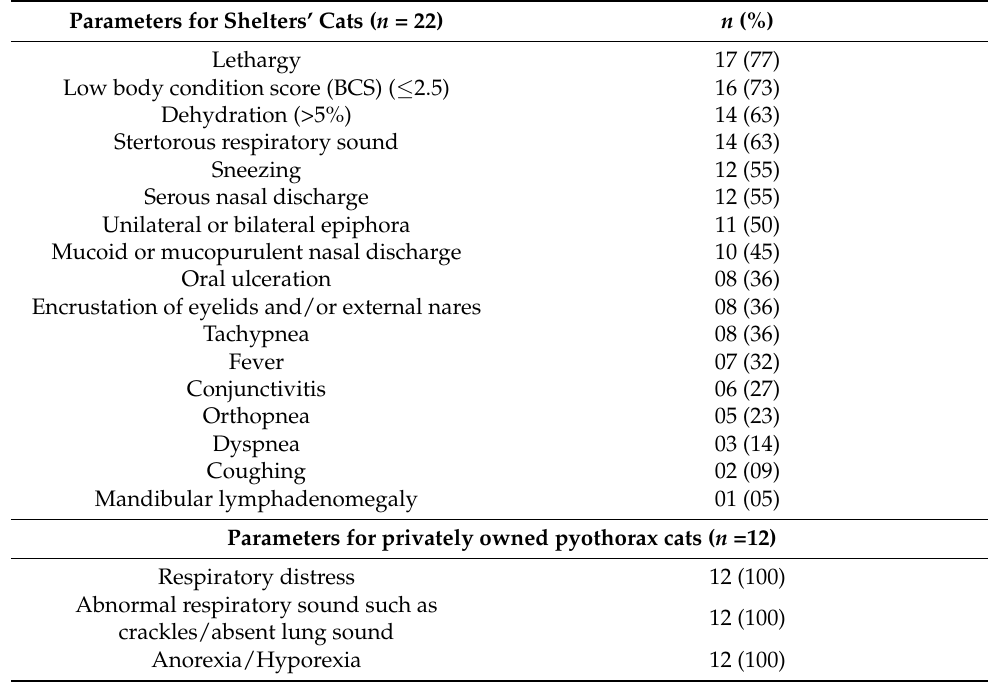
Table 3. Clinical findings in shelter ( n = 22) and privately owned cats ( n = 12) manifesting acute/chronic infectious respiratory disease